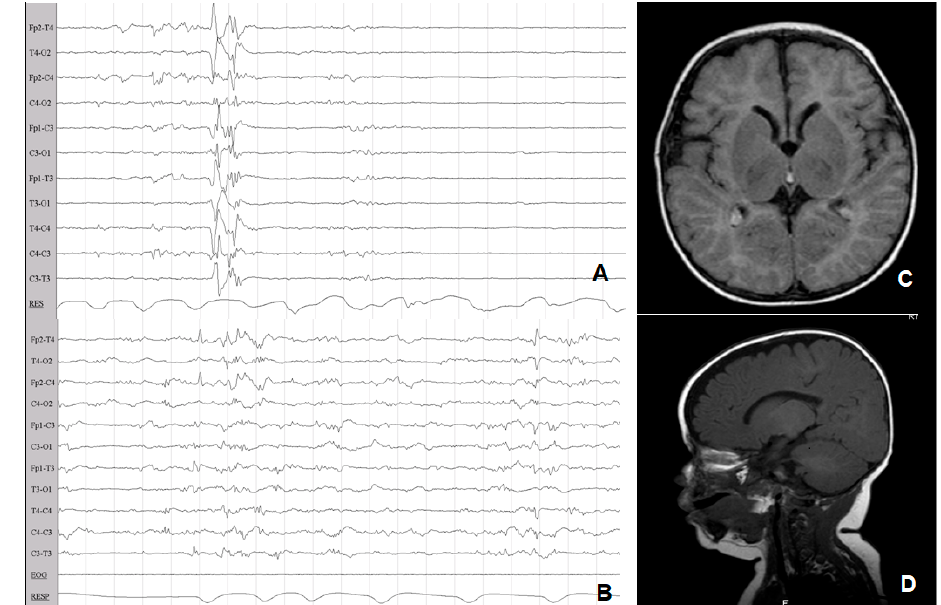
Figure 5. Patient 10 with severe HIE at enrollment and normal outcome at 24 months. ( A ): p-EEG at enrollment (3 h of life) showing severe EEG abnormalities (grade 3). ( B ): p-EEG at the end of TH showing mild EEG abnormalities (grade 1). ( C , D ): Normal cerebral MRI at 1 month of life.